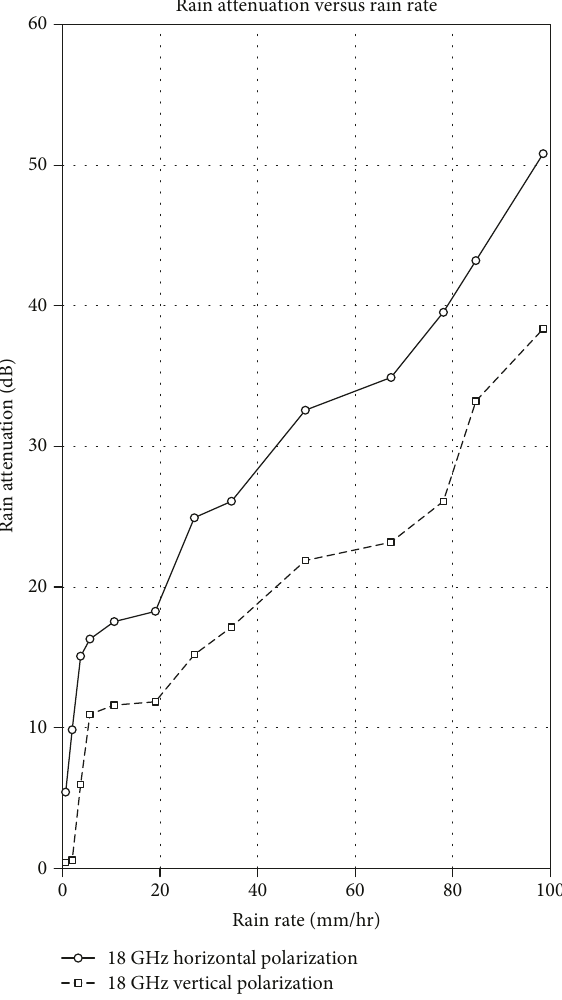
Figure 6: Rain attenuation against rain rate